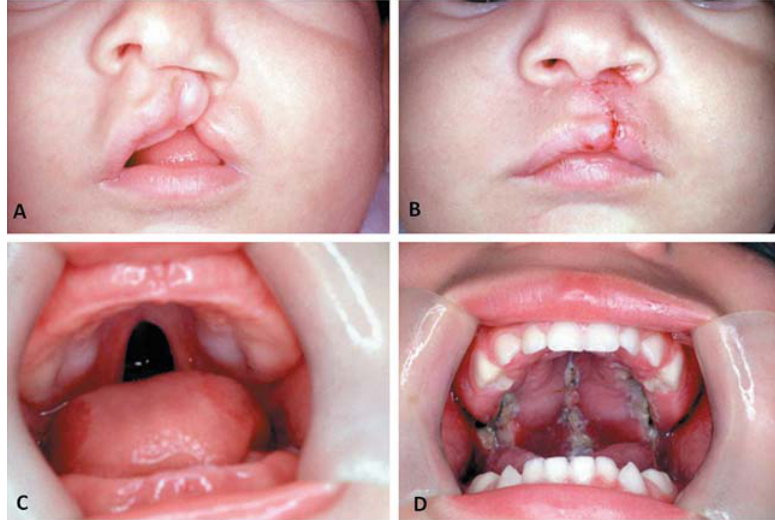
Figure 2- A and B – Pre- and postoperative aspect of cheiloplasty (surgical repair of the lip); C and D – Pre- and postoperative aspect of palatoplasty (surgical repair of the